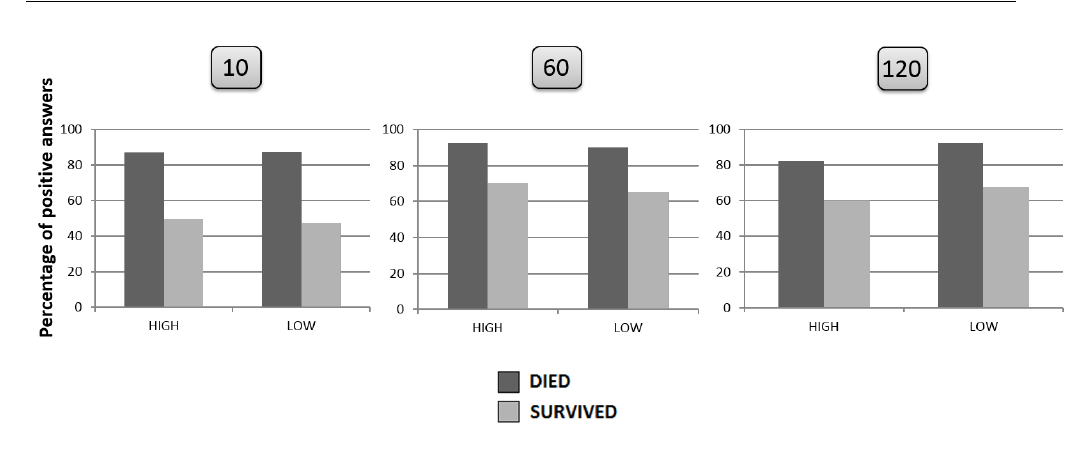
Figure 1 Percentages of positive answers by question, probability of sur- vival, and total number of